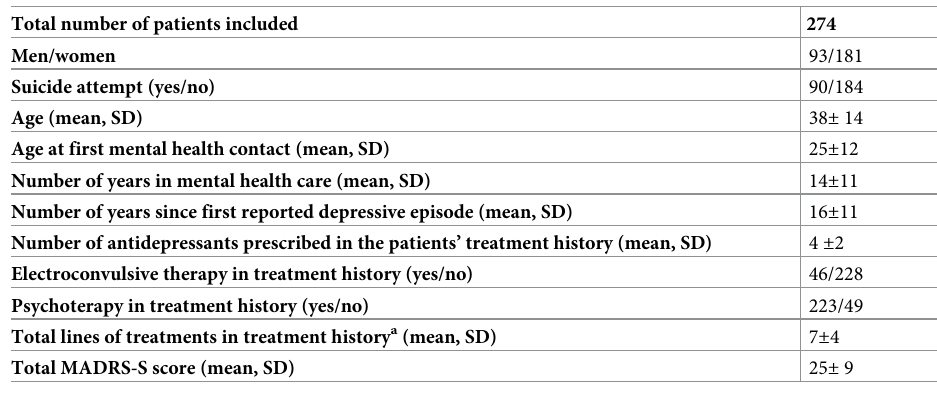
Table 1. Patient characteristics in the